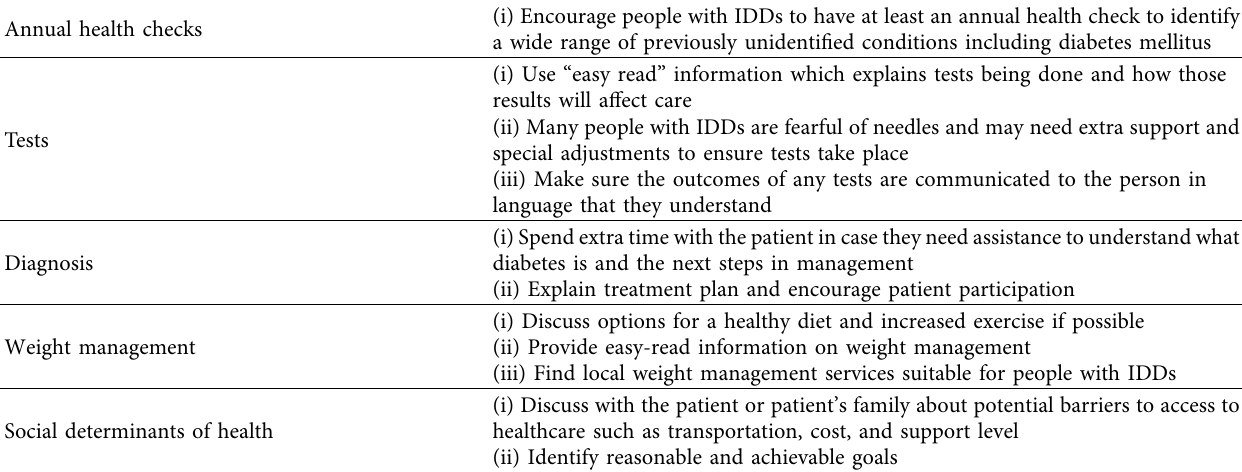
Table 2: Special considerations for providers managing adults with